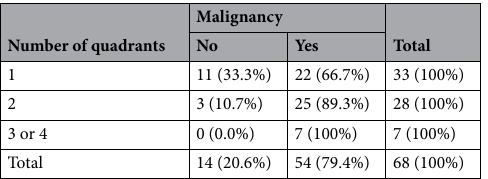
Table 2. A group of 68 patients/number of infiltrated quadrants versus malignancy.